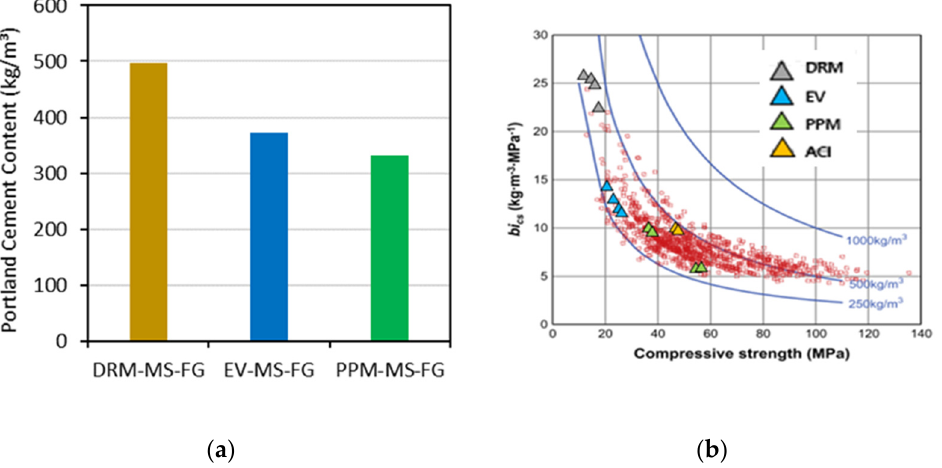
Figure 15. ( a ) Portland cement (PC) content levels for the mixtures in analysis; ( b ) relationship between bi and compressive strength at 28 days (adapted from [77]).